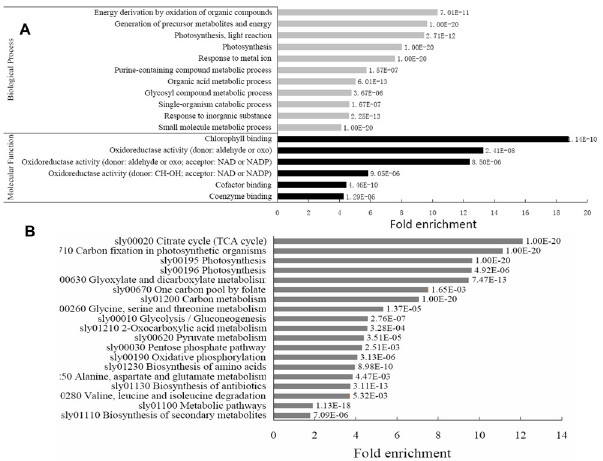
and molecular function (black bars) (A) and KEGG pathway enrichment analysis (p < 0.05) (B).